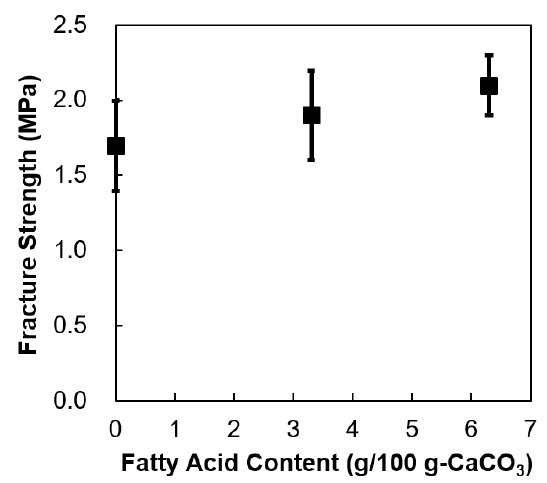
Figure 7. Average fracture strength of agglomerates as a function of the amount of fatty acid coating. Error bars show the standard errors.